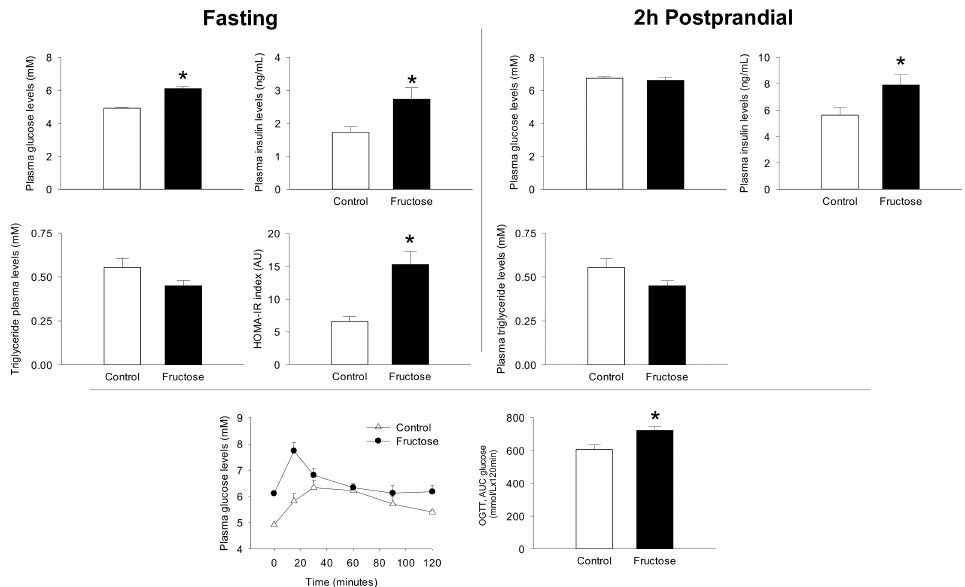
Figure 2. Upper panel: plasma glucose, insulin and triglyceride levels as well as HOMA-IR index at the fasting and postprandial state (2 h after the last meal) on rats after 45 days of feeding a control or high-fructose diet. Lower panel: plasma glucose levels and area under the curve (AUC) during oral glucose tolerance test (OGTT). Data is presented as mean ± SEM ( n = 8). * represent significant ( p < 0.05) differences between groups. ND, not detected.